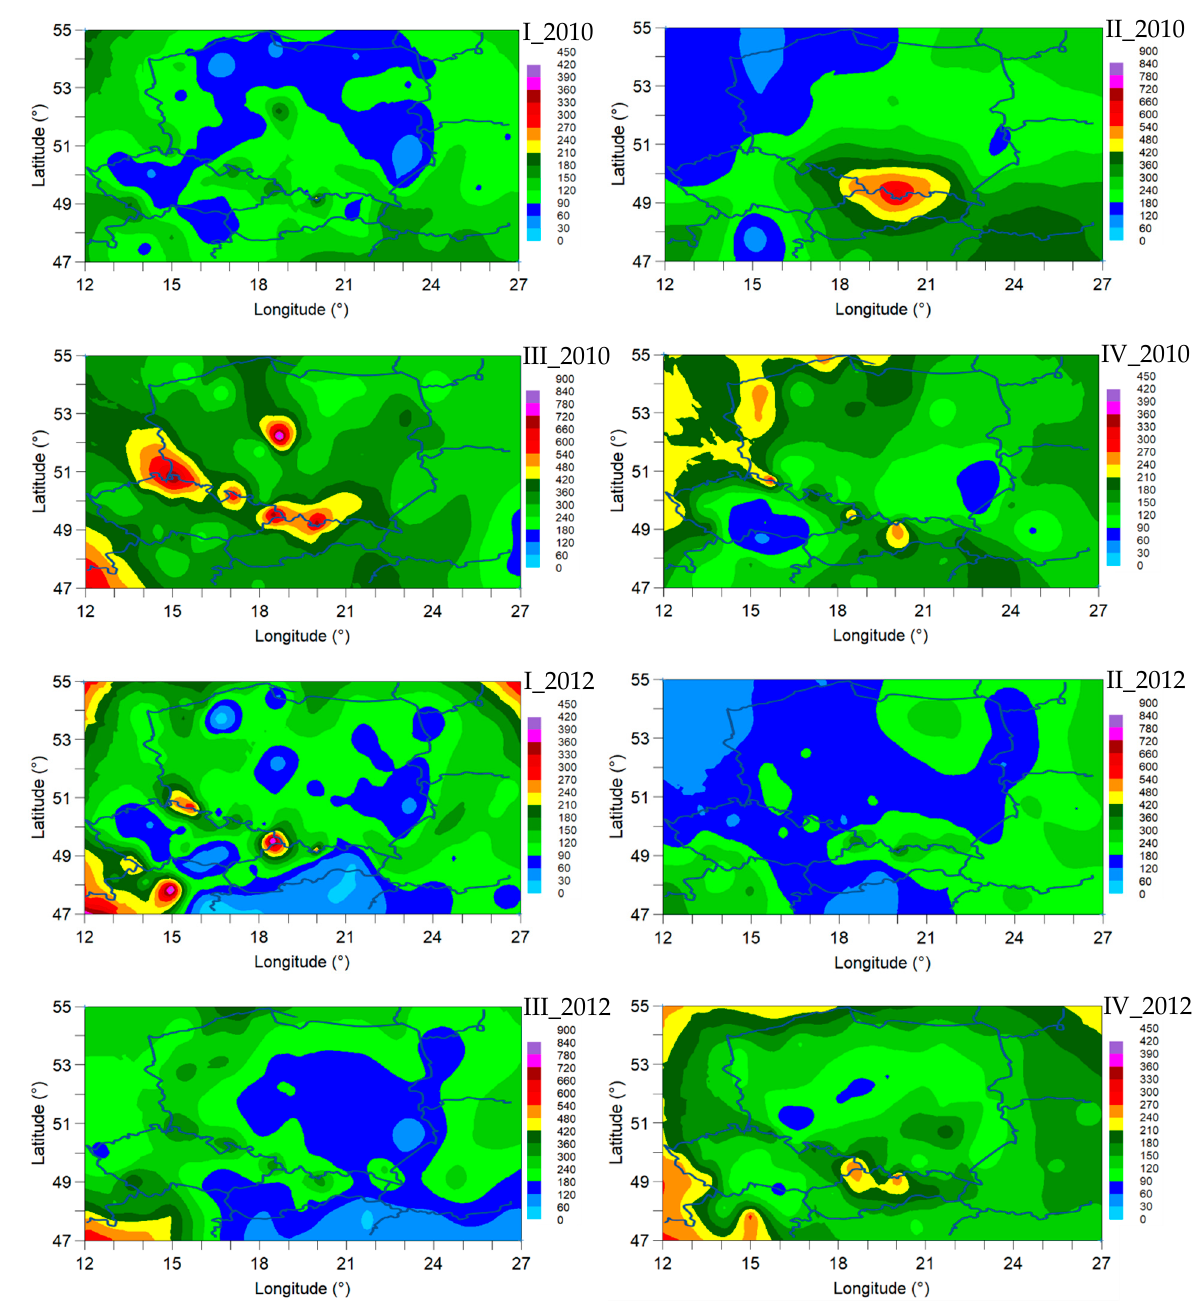
Figure 3. Figure 3. Spatial distribution of quarterly rainfall (2D maps) in Poland and neighbouring countries estimated by the or- 451 dinary cokriging interpolation method in 2010 and 2012 year. Note that the same colours represent twice higher precipi- 452 tation values in quarters II and III (0–900 mm) than in quarters I and IV (0–450 mm) (1° = approx. 100 km). Maps were 453 created using Gamma Design Software GS+10 [60].